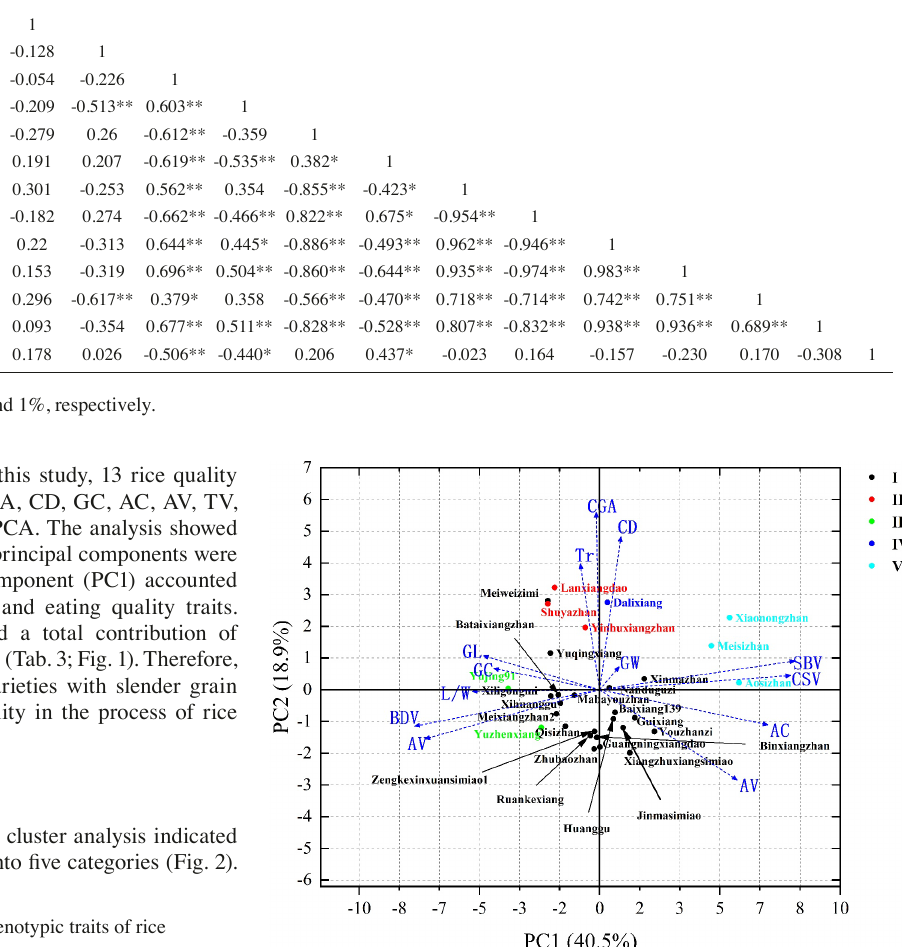
Tab. 3: Principal component analysis of 13 phenotypic traits of rice Traits Fig. 1: PCA Bi-plot. Thirteen rice quality traits and their importance in